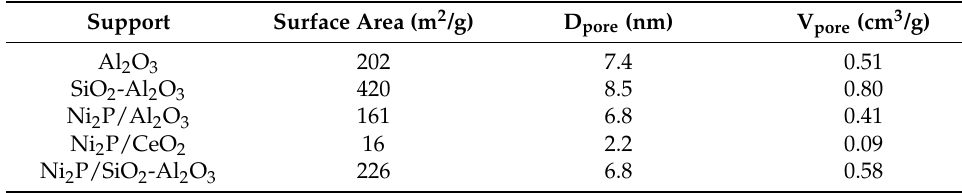
Figure 1. N 2 adsorption–desorption isotherms for the catalysts ´ series. Table 1. Textural properties of the prepared